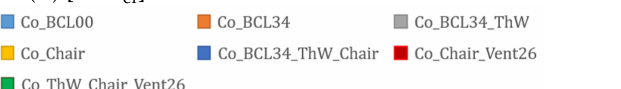
Figure 15. Winter (15.10 – 15.03): ( a ) Overall comfort values for the different controllers (n = 14496), ( b ) Thermal heating and cooling demand [kWh el /m²], ( c ) Used electrical end energy for heating and cooling with consideration of a reversible heat pump (COP Heating = 3, COP Cooling = 2) and used energy for the decentralized systems [kWh el ], ( d ) Electrical energy of the decentralized systems, thermoelectric wall (ThW), chair (Ch), fan (V) [kWh el